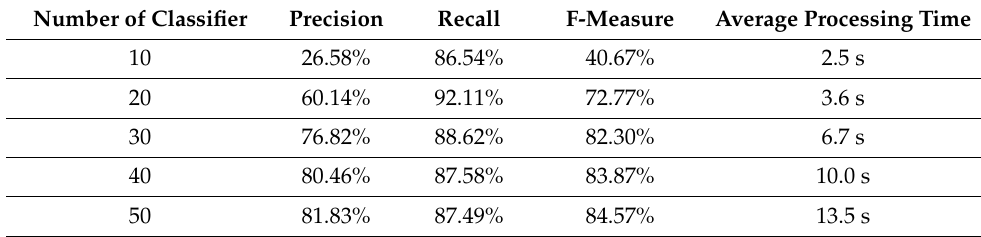
Table 10. Detection speed of each